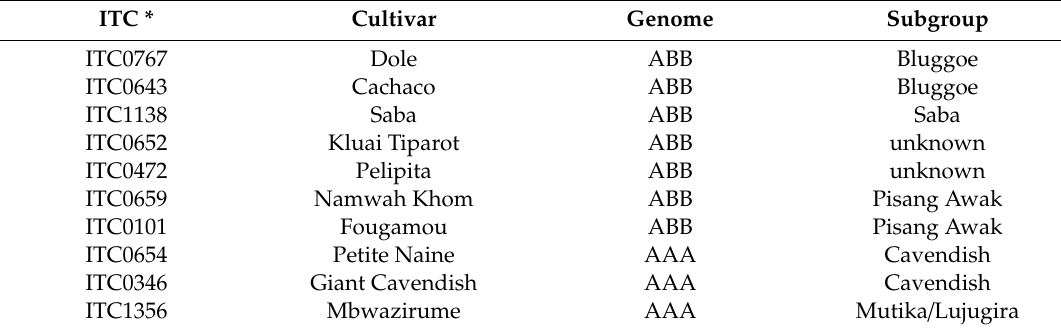
Table 1. List of banana cultivars studied for antimicrobial